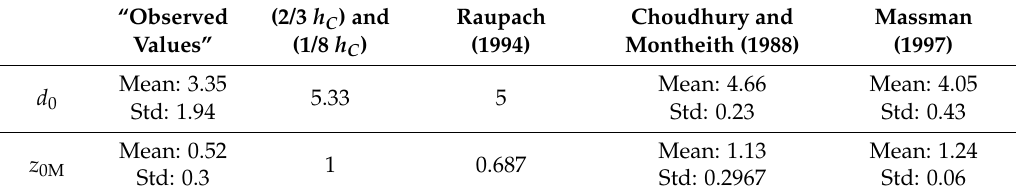
Table 3. Different average values (m) of d 0 and z 0M using the different approaches (“observed” values are computed using Rooney [47] and Nakai et al. [48] as described in the previous section) for Las Majadas.